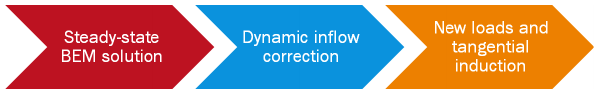
Figure 1. Process of induced-velocity correction by the dynamic inflow model. Note that the “steady-state BEM solution” item only refers to the use of classical momentum theory and unsteady airfoil effects are included in the evaluation of the instantaneous airfoil co- efficients according to the selected model (e.g. Snel, 1997; Hansen et al.,